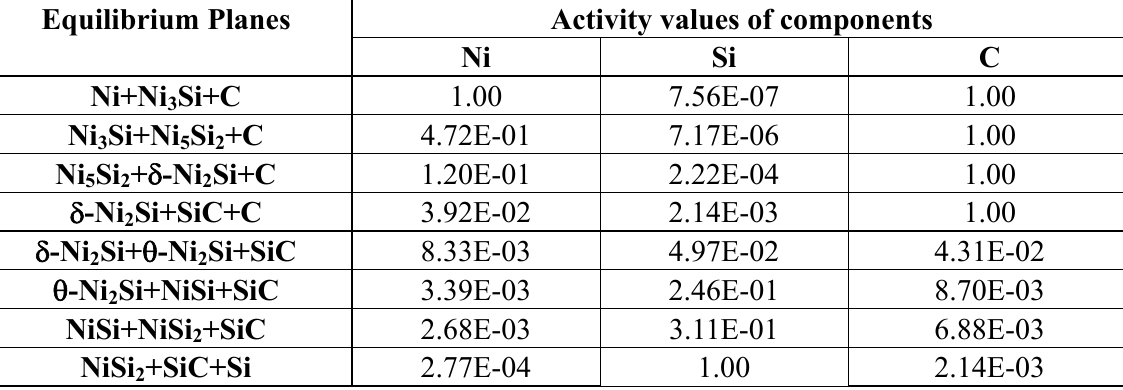
Table 2. The estimated activity values of each component in a designated ternary equilibrium plane at 900 ° C [6].